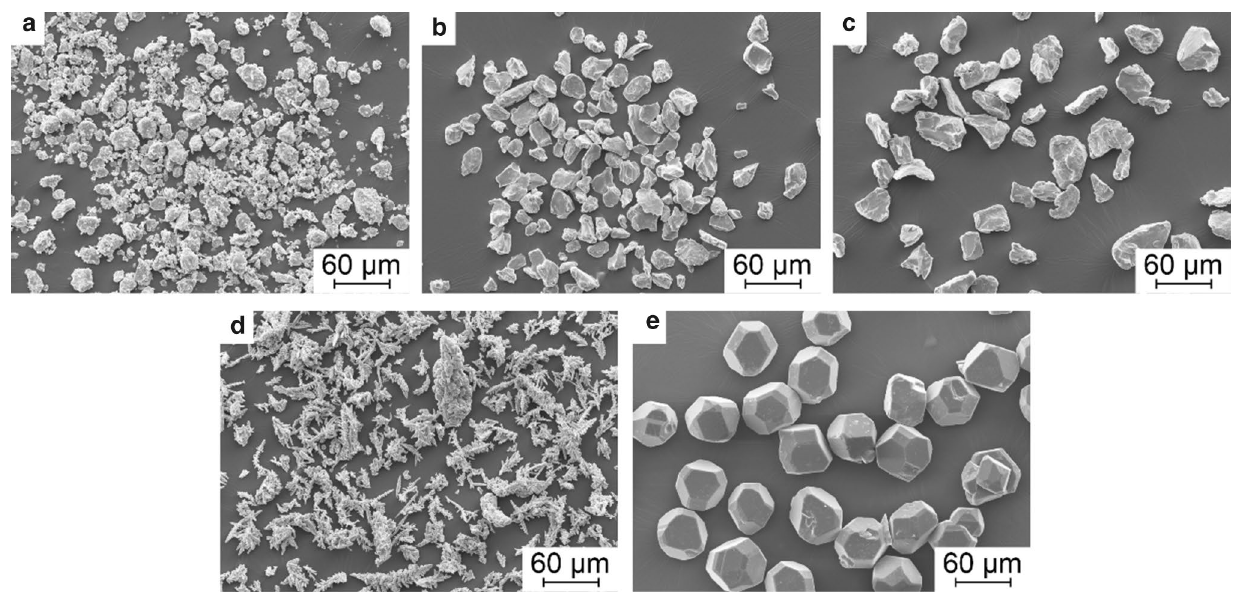
Fig. 1 SEM microphotographs of the used raw materials: Chromium powders with an average particle size of 10 µm ( a ), a particle size below 25 µm ( b ), and below 45 µm ( c ). Copper powder with a particle size below 45 µm ( d ). Diamond powder with a particle size of 38–45 µm ( e ) Fig. 2 Exemplary sinter- ing course of pressure and temperature at a sintering temperature of 900 °C, a pres- sure of 35 MPa, and holding times of 900 s and 1200 s (left).